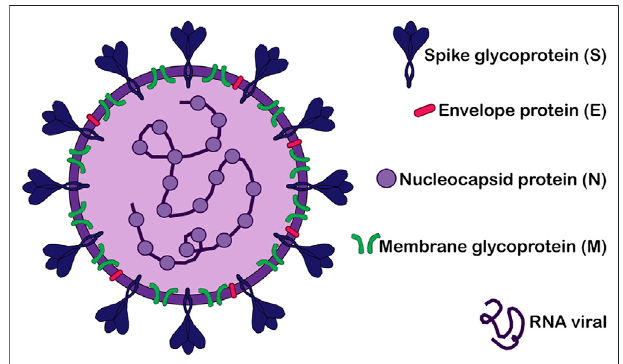
FIGURE 1 | Structure of SARS-CoV-2. Schematic representation of SARS-CoV-2 virus structure highlighting its four major structural proteins: the spike glycoprotein ( S ), the envelope protein ( E ), the nucleocapsid protein ( N ) and the membrane glycoprotein ( M ). The RNA viral is also